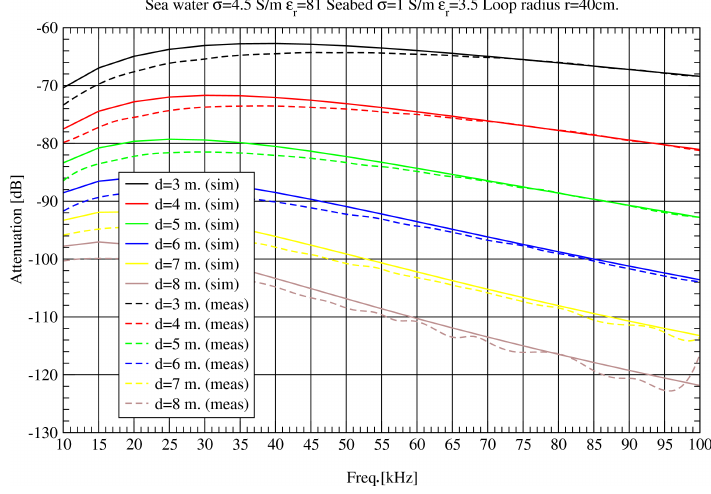
Figure 11. Path loss (dB) comparison up to 8 m (10 KHz–100 KHz).